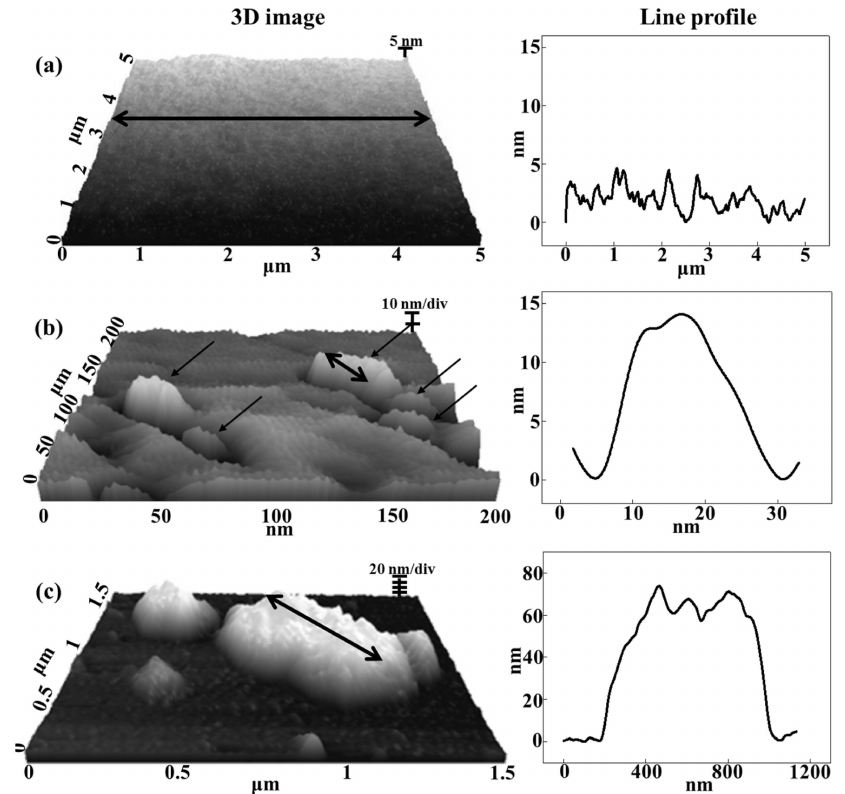
Figure 3. Three-dimensional atomic force microscopic (AFM) images and corresponding line profiles along the double-headed arrow for ( a ) agarose only hydrogel (1 wt/v% agarose concentration, A-1), ( b ) LDH-agarose composite hydrogel (1 wt/v% agarose concentration, C-1) and ( c ) LDH-agarose mixture hydrogel (1 wt/v% agarose concentration, M-1), respectively. Single-headed arrows in ( b ) stand for singe LDH nanoparticles distributed in agarose